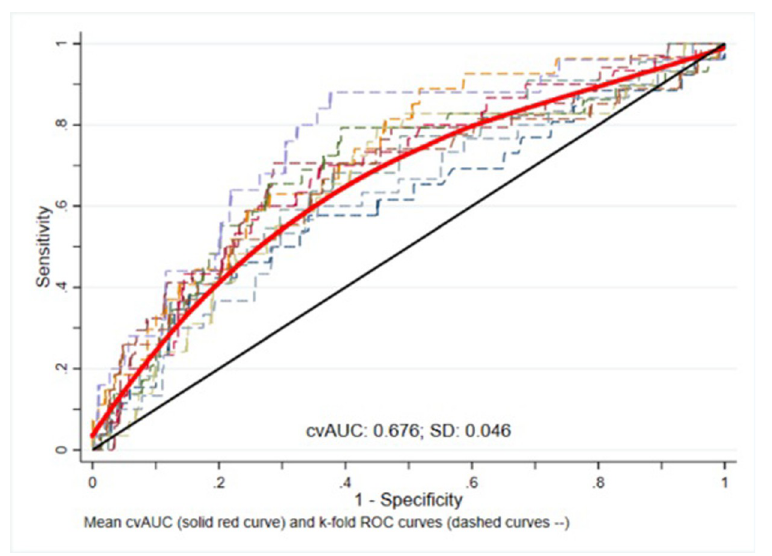
Fig 3. 10-fold cross validation plot to validate cutoff in total population.